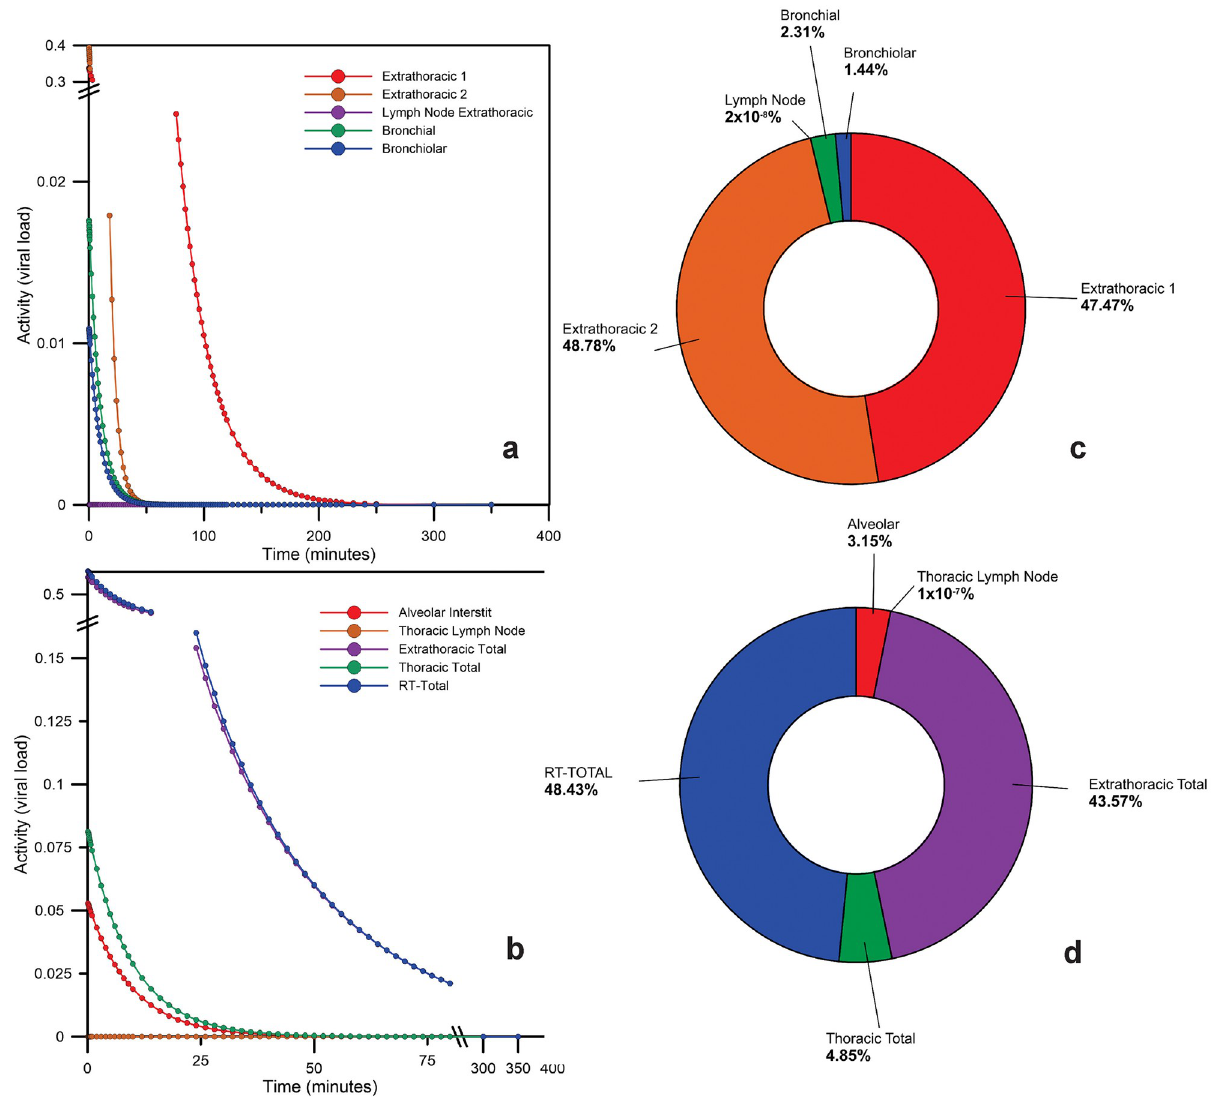
Fig 2. Time-dependent particle transport from each respiratory tract region in the compartments of the model for SARS-Cov-2 (after 1 minute of exposure): (a) and (b) time response curves; (c) and (d) fractions of the initial intake of the virus by ET 1 pathway.